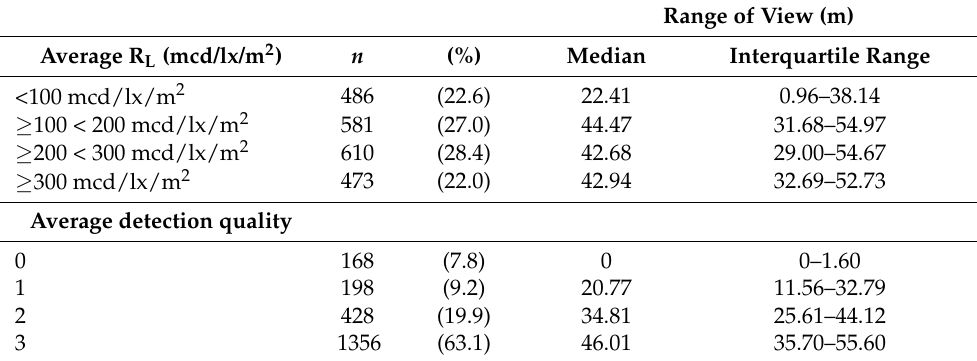
Table 3. Summary of descriptive